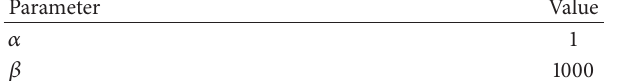
Figure 10: Speed bump test.